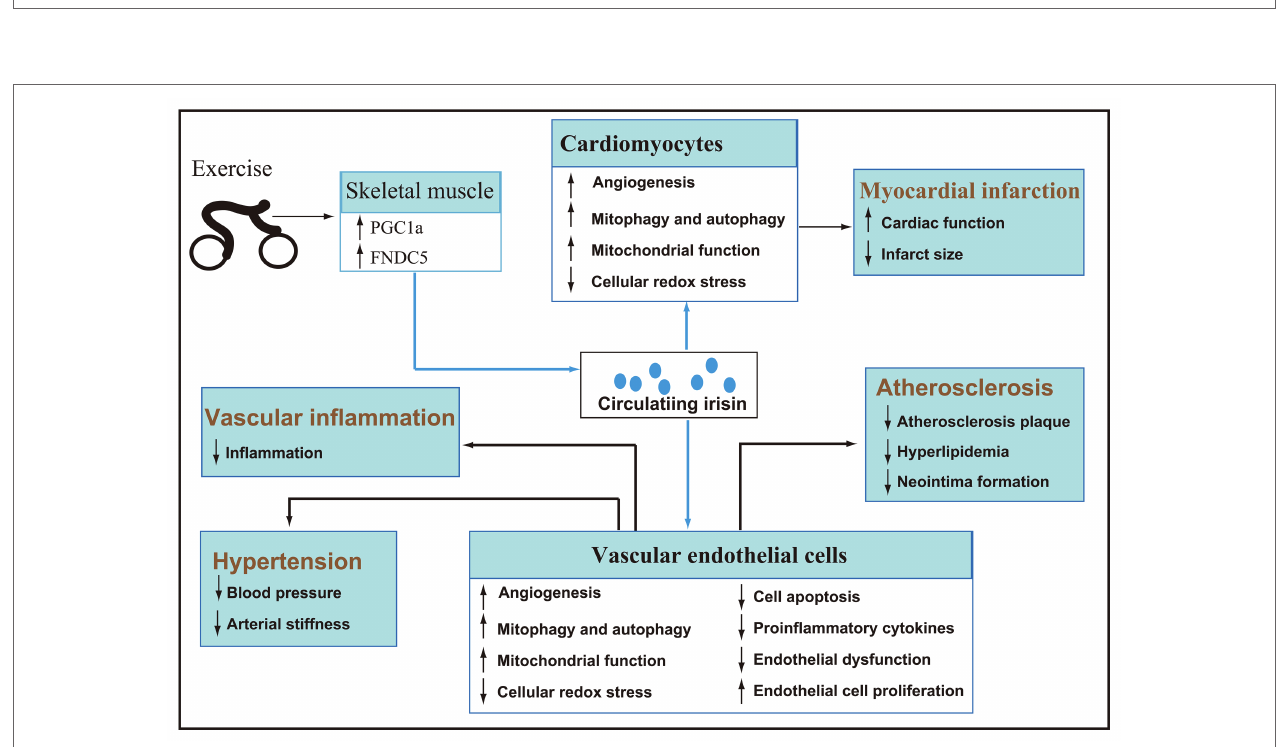
FIGURE 3 | After secreted by skeletal muscle during exercise, irisin reaches cardiomyocytes and vascular endothelial cells via blood circulation (blue line). Irisin can promote angiogenesis, autophagy, and endothelial cell proliferation, improve mitochondrial function, inhibit cellular redox stress, apoptosis, inflammation, and endothelial dysfunction, and then play a key role in improving hypertension, myocardial infarction, atherosclerosis, and vascular